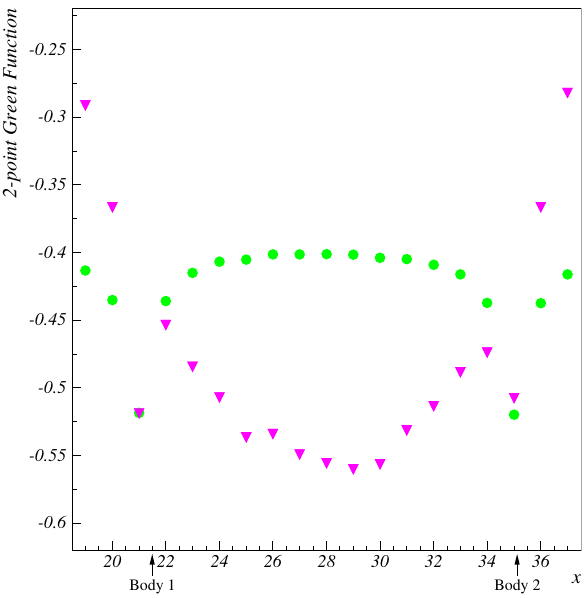
Fig. 5 The potential for the ( g φ∂ μ φ∂ μ φ + g 2 φ 2 ∂ μ φ∂ μ φ ) theory ( tri- angles ). The circles are the free-field case ( g = 0). The two sources are located on the x -axis at d = ± 7 from the lattice center x center = 28, y = 0 and z = 0. The coupling is g = 7 . 5 × 10 − 3 , the lattice size is N = 85, the decorrelation parameter is N cor = 20 and N s = 3 . 5 × 10 4 paths were used. To conveniently compare the results, a constant offset is added to the free-field case so that the potentials at the position of the first source, x = 21, match